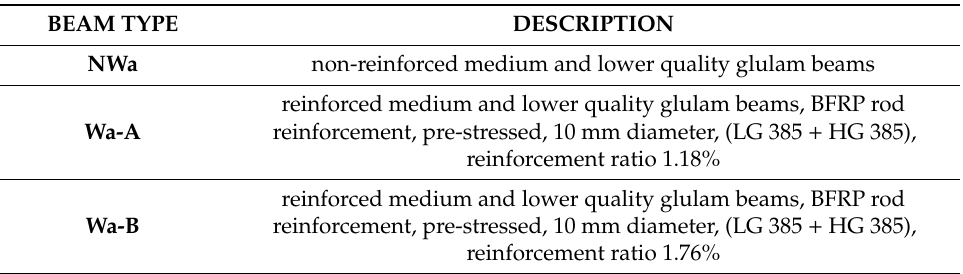
Table 1. Specification of the types of beams made from medium and lower quality class wood, reinforced with a pre-stressed BFRP rod with a “loading-relief” scheme ( Pinus sylvestris L.), (including LG—epoxy resin series, HG—hardeners